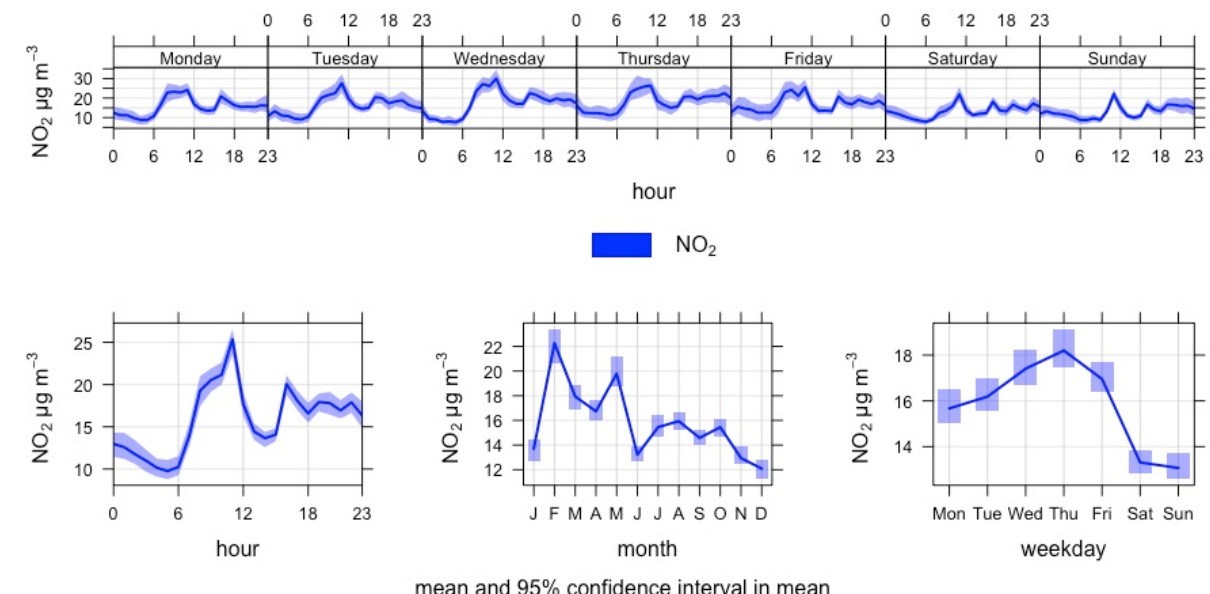
Figure 8. Time variation plot of NO 2 concentration at Helsinki South Harbour in 2018.